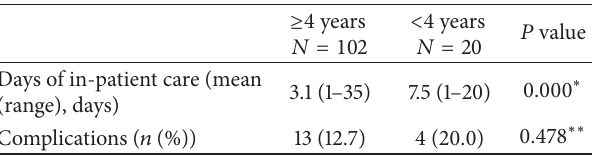
Table 5: Hospital stay and